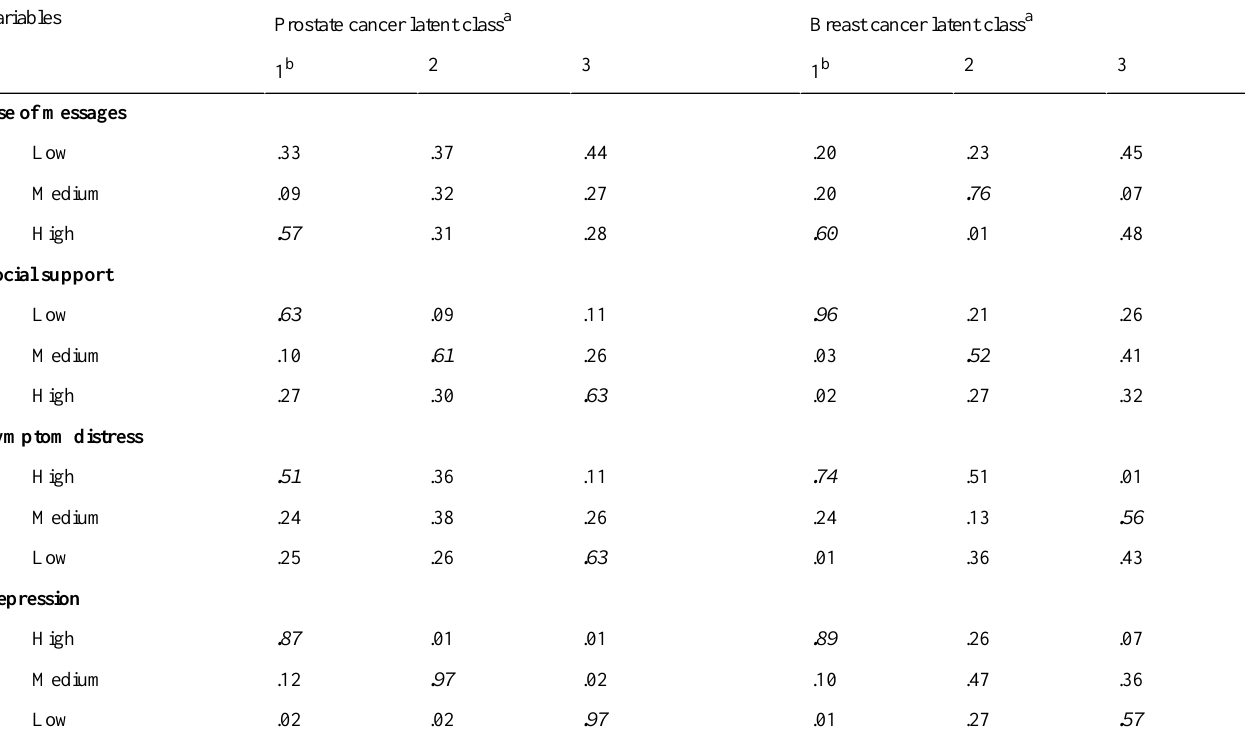
Table 7. Use of the message component in WebChoice (in minutes). Latent class model, association with levels of social support, symptom distress, and depression. The numbers represent item probabilities. All models were stratified by diagnosis and adjusted for age at